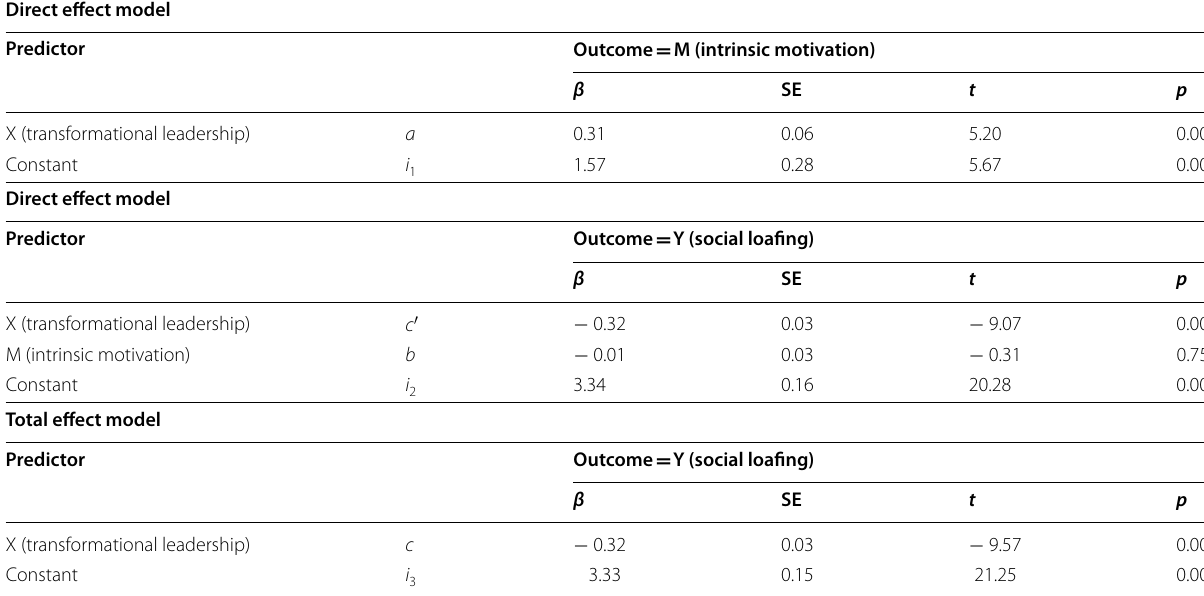
Table 6 Results of simple mediation model for social